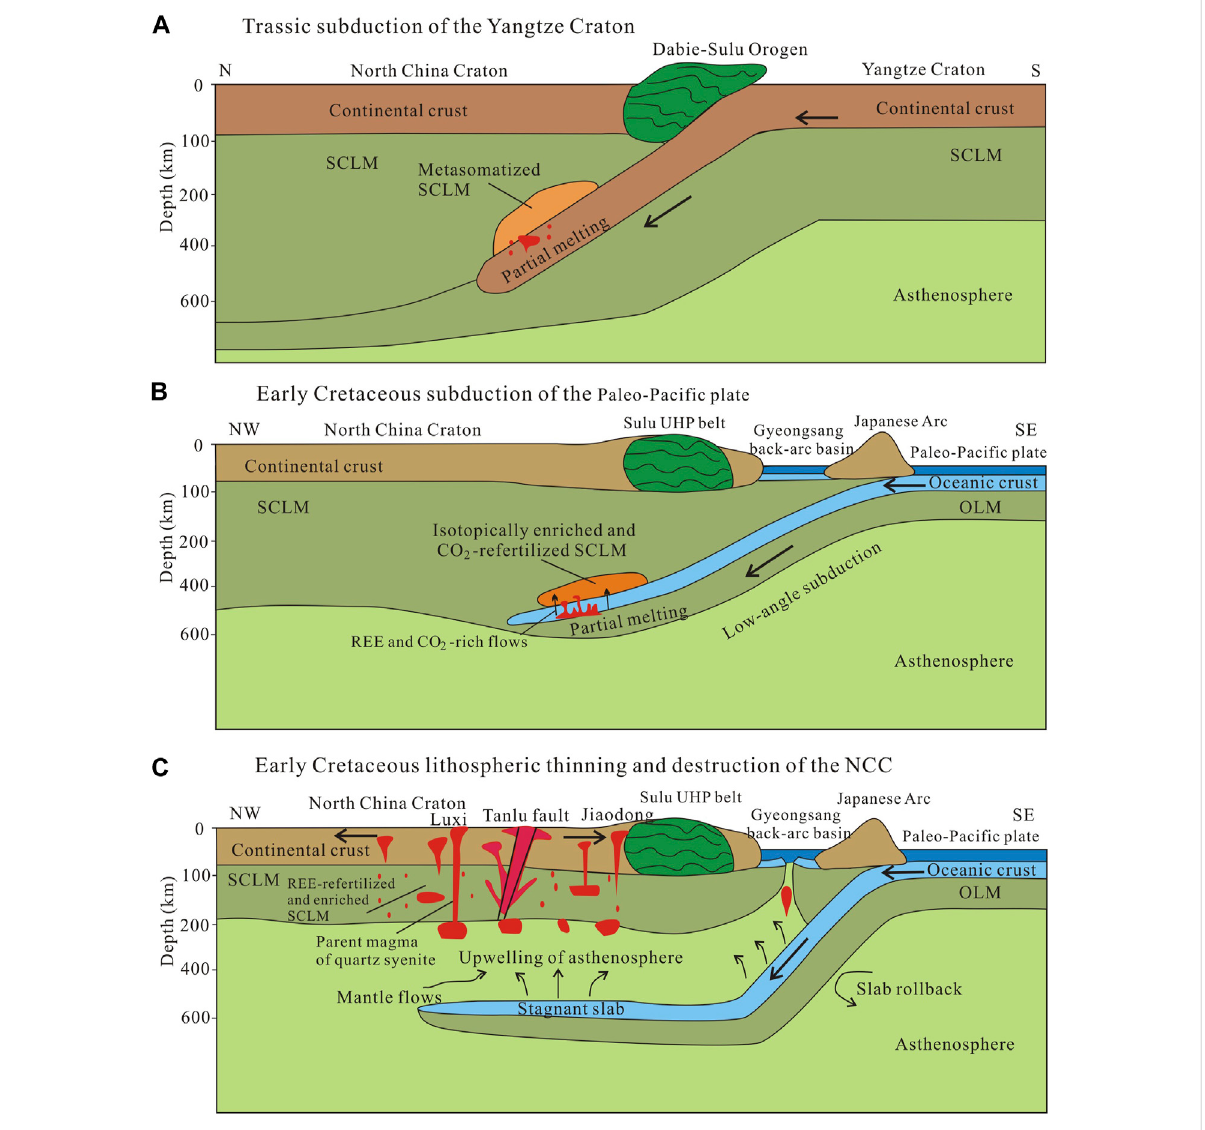
FIGURE 11 Simpli fi ed genetic model cross-sections of quartz syenite (modi fi ed after Zhu and Xu, 2019; Deng et al., 2020; Ding et al., 2022). (A) Trassic subduction of the Yangtze Craton. (b) Early Cretaceous subduction of the Paleo-Paci fi c plate. (C) Early Cretaceous lithospheric thinning and destruction of the